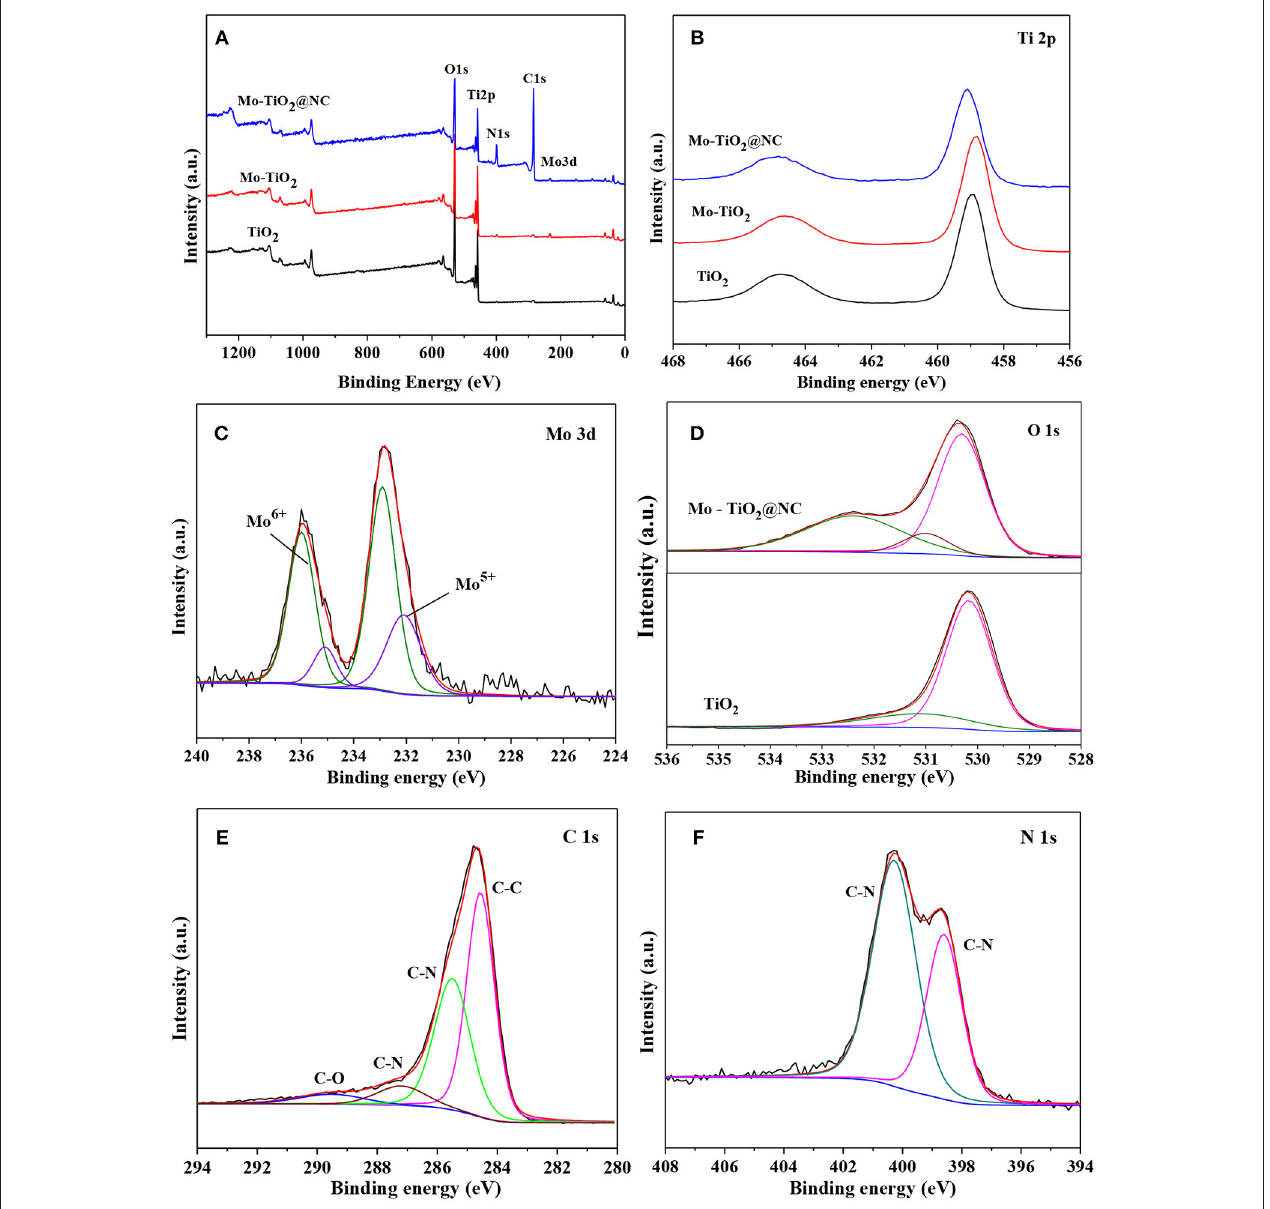
FIGURE 3 | (A) Full XPS spectra of TiO 2 Mo-TiO 2 , and Mo-TiO 2 @NC, (B) Ti 2p XPS spectra of TiO 2 Mo-TiO 2 and Mo-TiO 2 @NC, fitted XPS spectra of Mo (C) , O (D) , C 1s (E) , N 1s (F) of Mo-TiO 2 @NC.